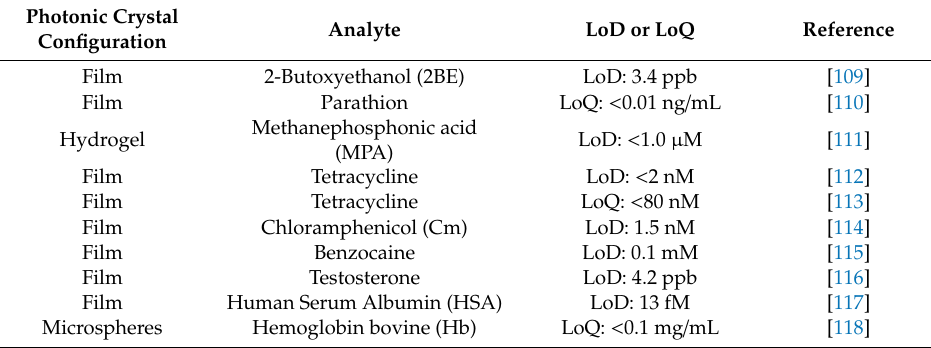
Table 3. MIPs coupled to photonic